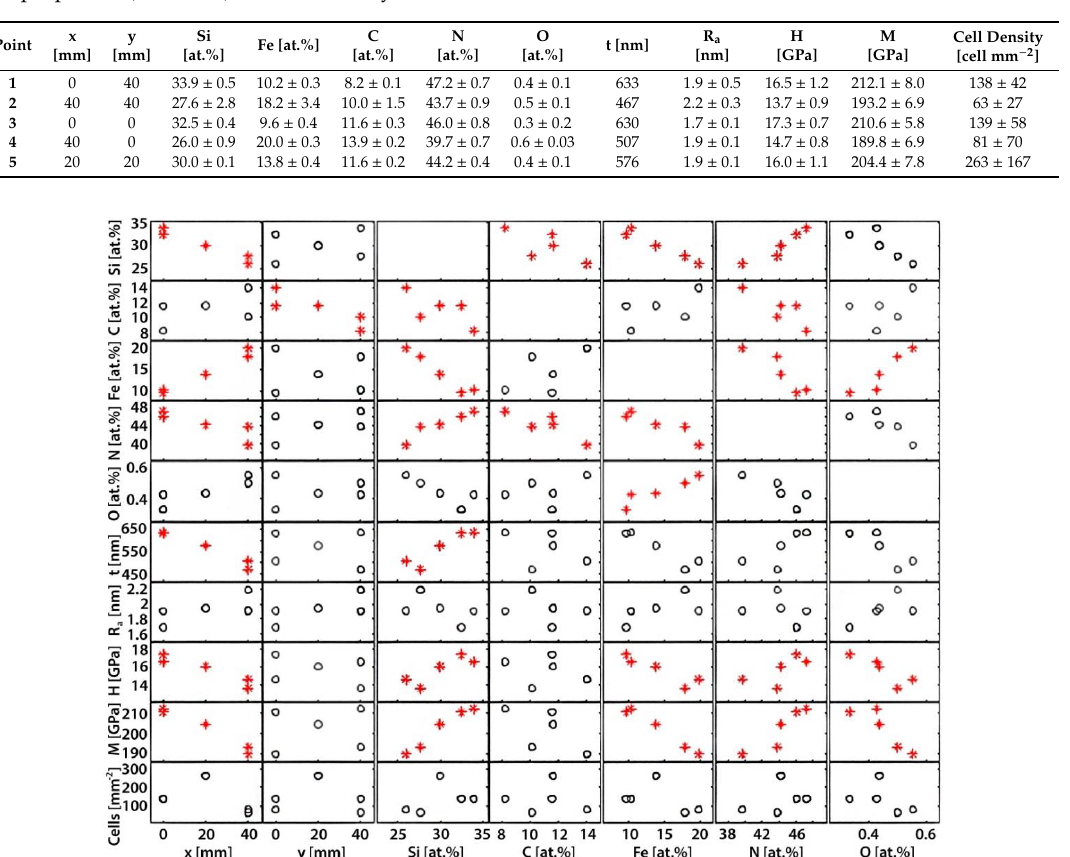
Table 1. The obtained composition (Si, Fe, C, N and O), thickness, surface roughness, mechanical properties (H and M) and cell density.